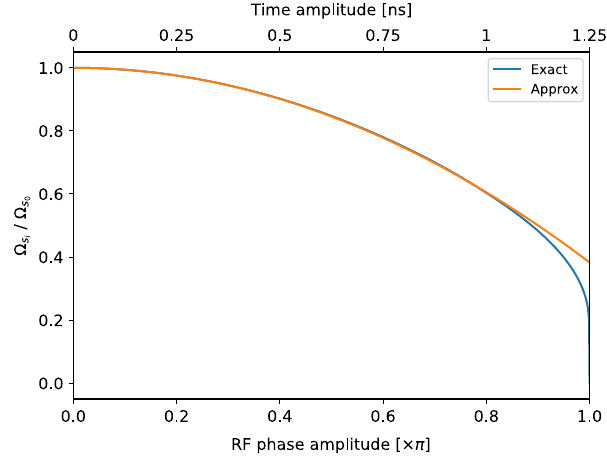
FIG. 1. Comparison between the exact [Eq. (3)] and approxi- mate [Eq. (4)] expressions for the synchrotron frequency as a function of the oscillation